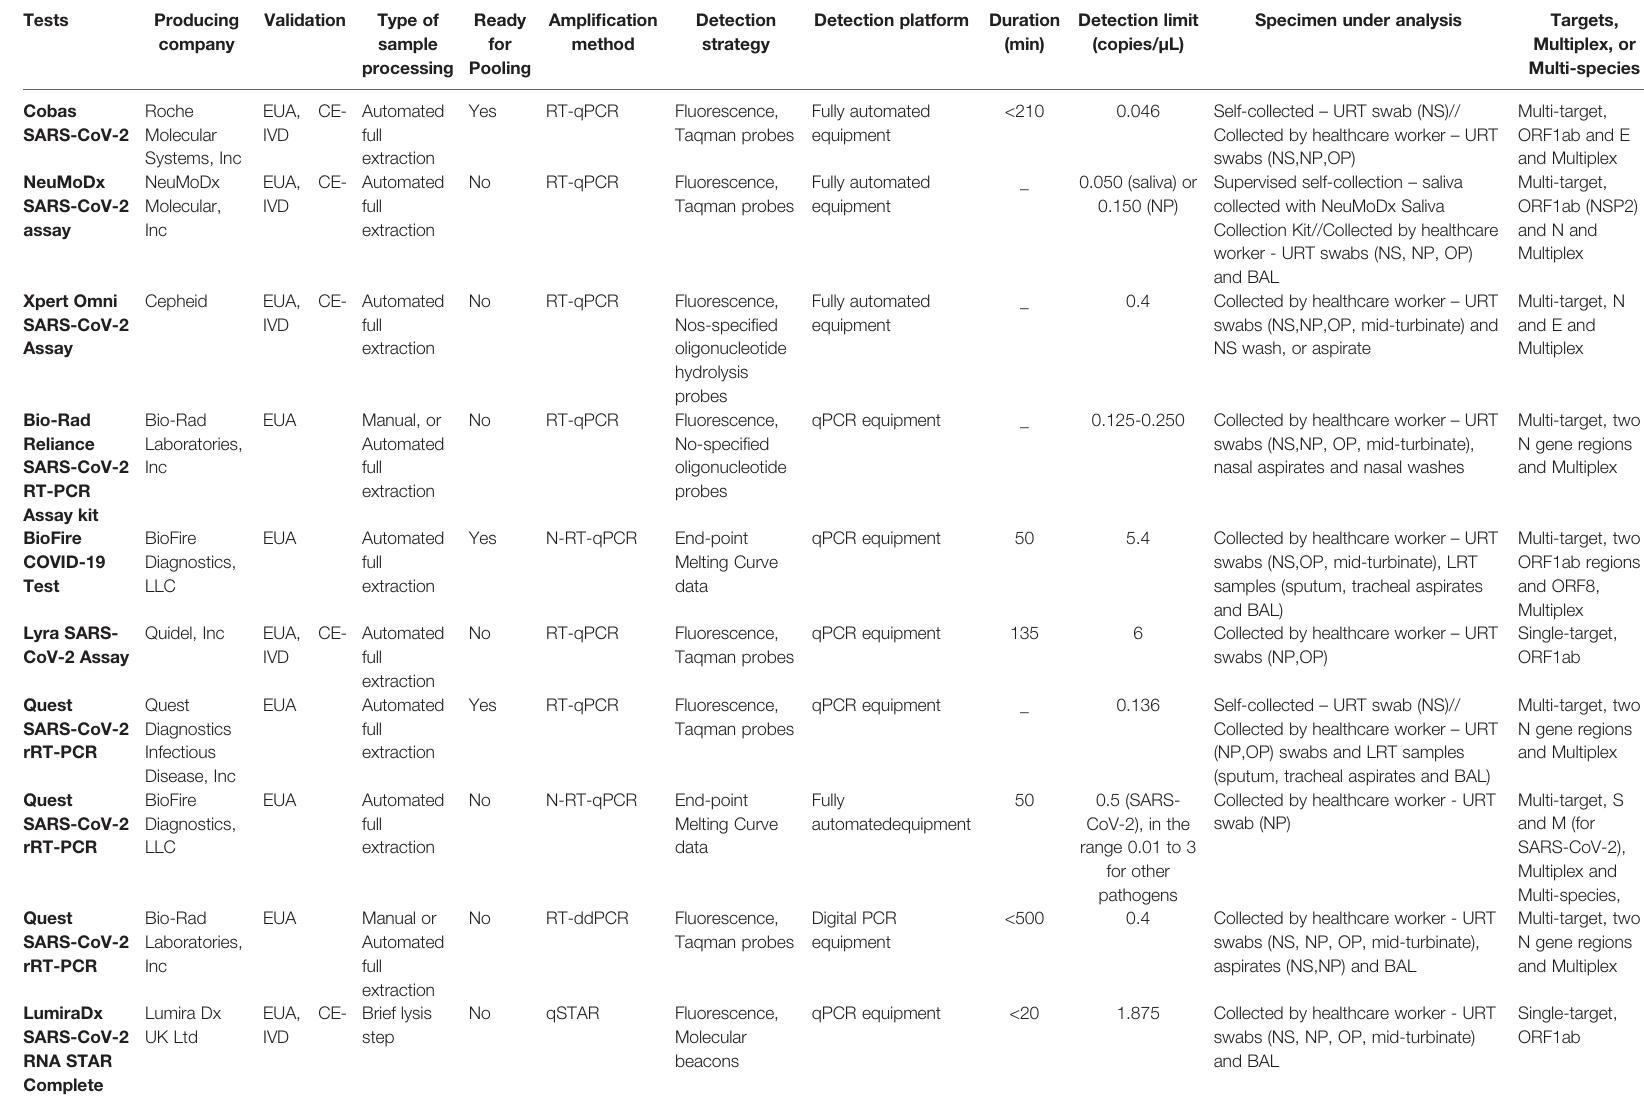
TABLE 8 | Benchmarking of diagnostics for SARS-CoV-2 based on non-isothermal ampli fi cation methods issued with EUA, or CE